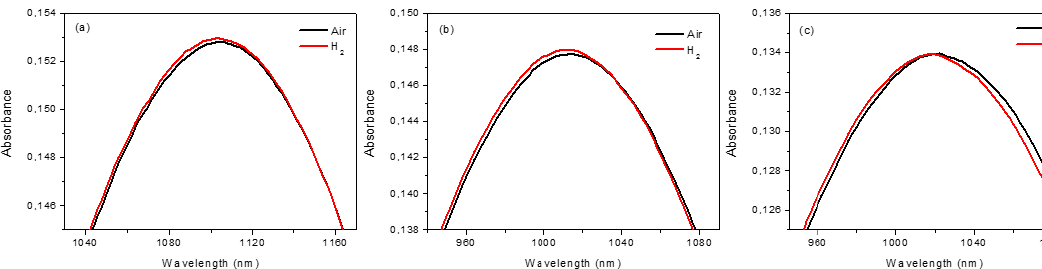
Figure 2. ( a ) Optical absorption spectrum in the 200–2000 nm range and ( b , c ) SEM images of Au NDs array on quartz with diameter of 150 nm and height of 5 nm. Scale bars are 500 nm.